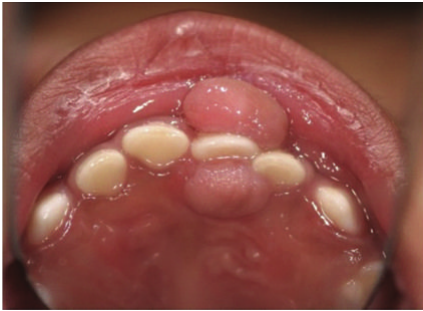
Figure 1: Buccal and palatal lesions.